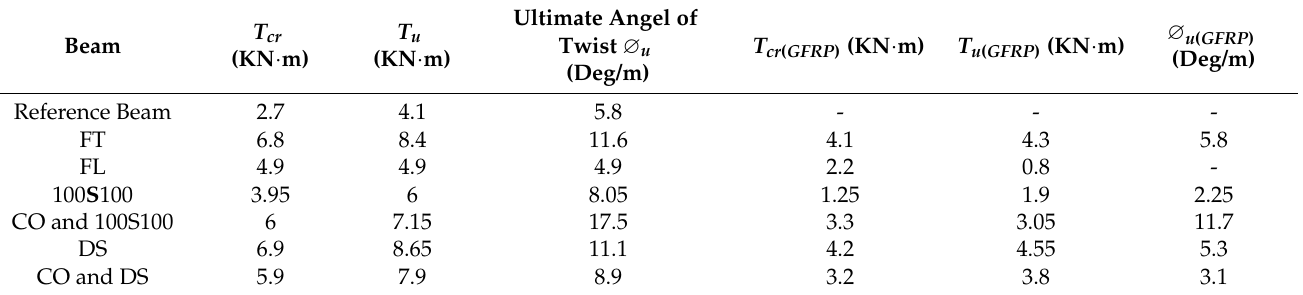
Table 4. Cracking torque, ultimate torque, ultimate angle of twist, and effects of fibers on the cracking torque, ultimate torque, ultimate angle of twist for FT, FL, 100s100, CO and 100s100, DS, and CO and DS (experimental study).